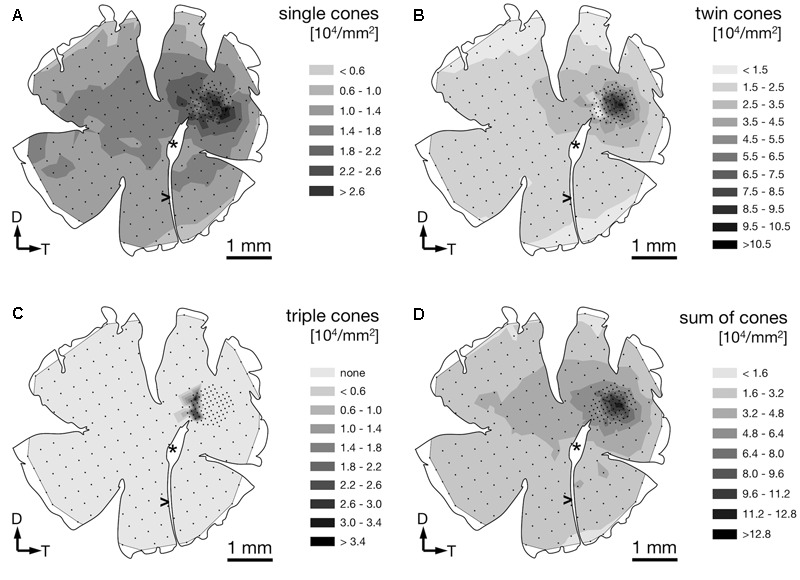
Retinal topography of single cones (A), twin cones (B), triple cones (C), and the summed density of all cones (D) in a representative individual. The maps show the left retina of one T. delaisi individual. The central hole and the gap extending nasoventrally are from the optic nerve head (∗) and falciform process (>). Black dots in the map correspond to counting sites. Arrows indicate dorsal, D; and temporal, T, direction.